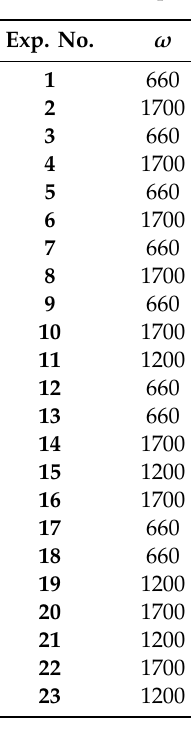
Table 3. Experimental test